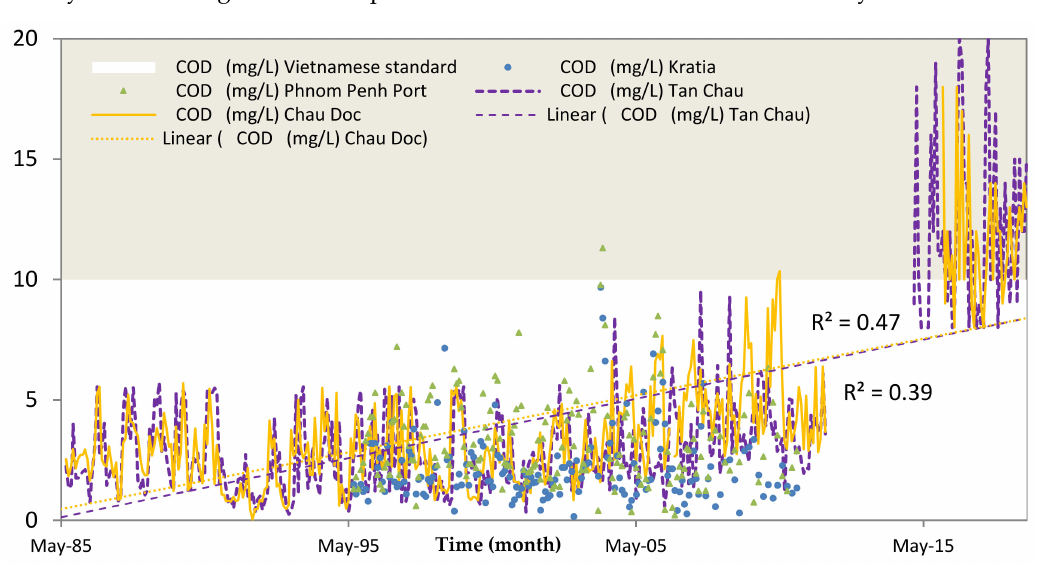
Figure 9. Temporal concentrations of chemical oxygen demand (COD) in the Vietnamese side (Tan Chau and Chau Doc stations) from 1985 to 2017 and in the Cambodia side (Phnom Penh Port and Kratie) from 1995 to 2010.